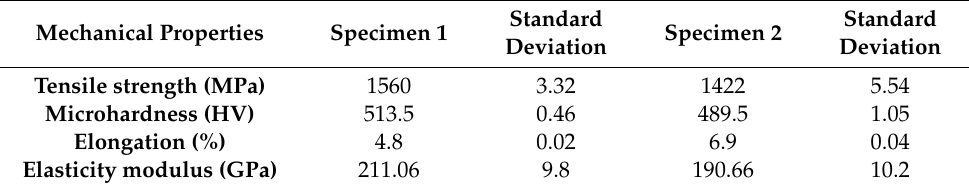
Table 3. The mechanical properties of the specimens.